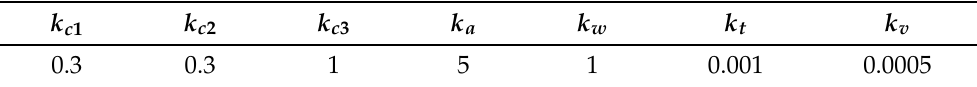
Table 1. Control